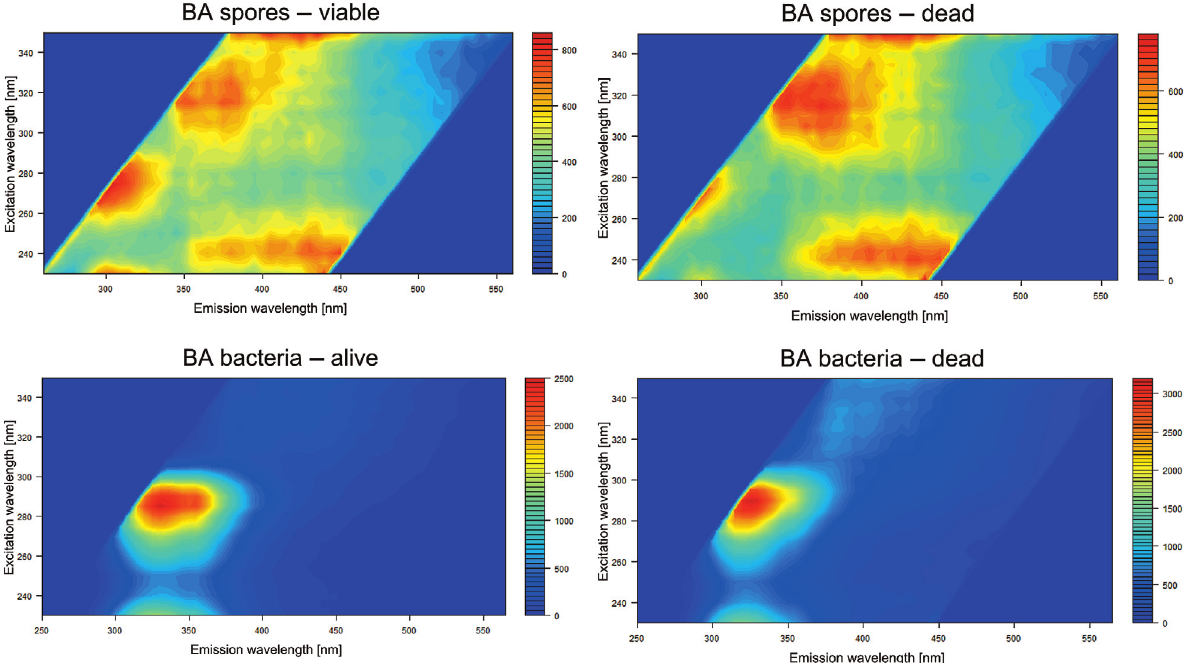
Fig. 5. SFS spectra of viable BA spores (top left), VHP-killed BA spores (top right), living BA bacteria (bottom left) and VHP-killed BA bacteria (bottom right). In SFS spectra, the vertical axis marks the excitation wavelength, the horizontal axis shows the emission wavelength and the spectral intensity is